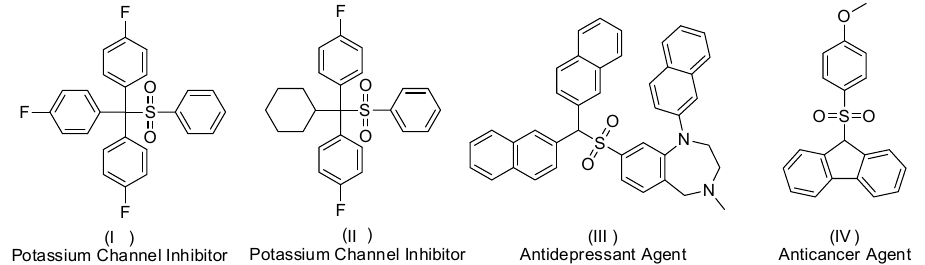
Figure 1. Representative biologically active diarylmethyl sulfone derivatives.